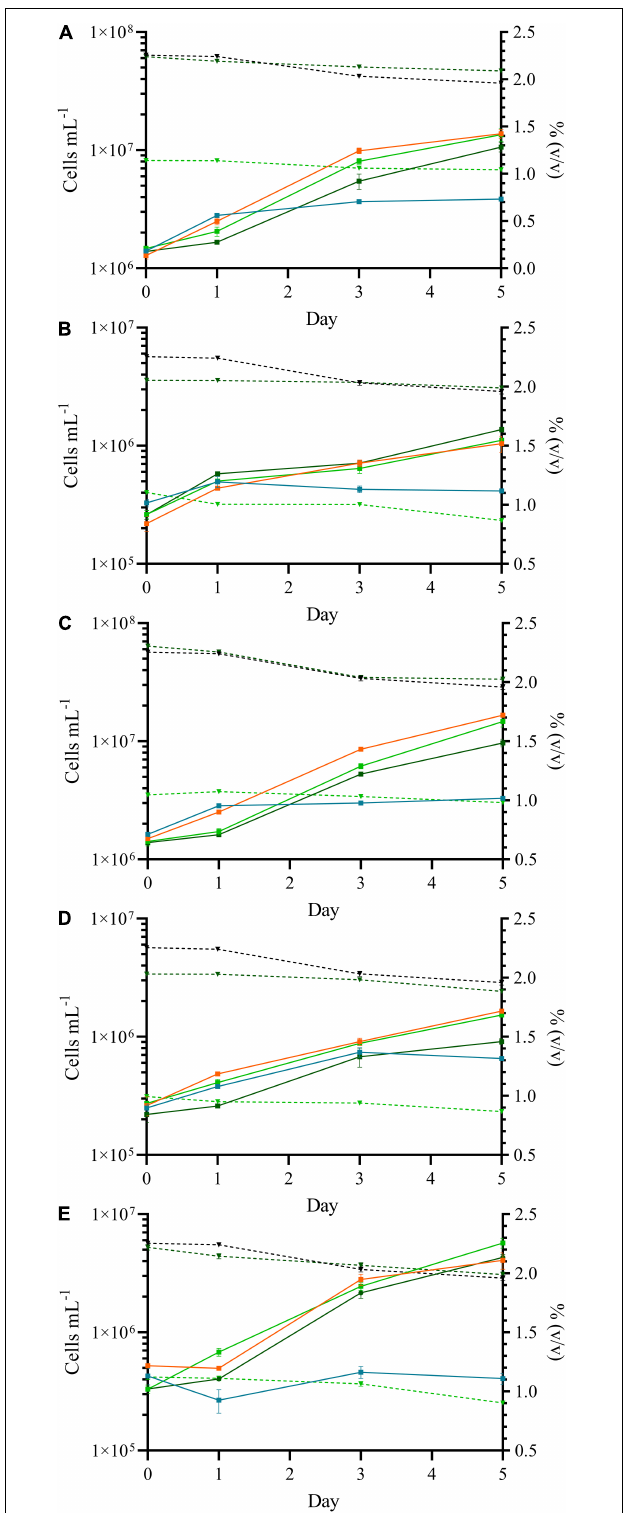
FIGURE 3 | Growth curves of Chlorella vulgaris (13–1) (A) , Chlorococcum sp. (MC-1) (B) , Coelastrella sp. (3–4) (C) , Desmodesmus sp. (2–6) (D) and